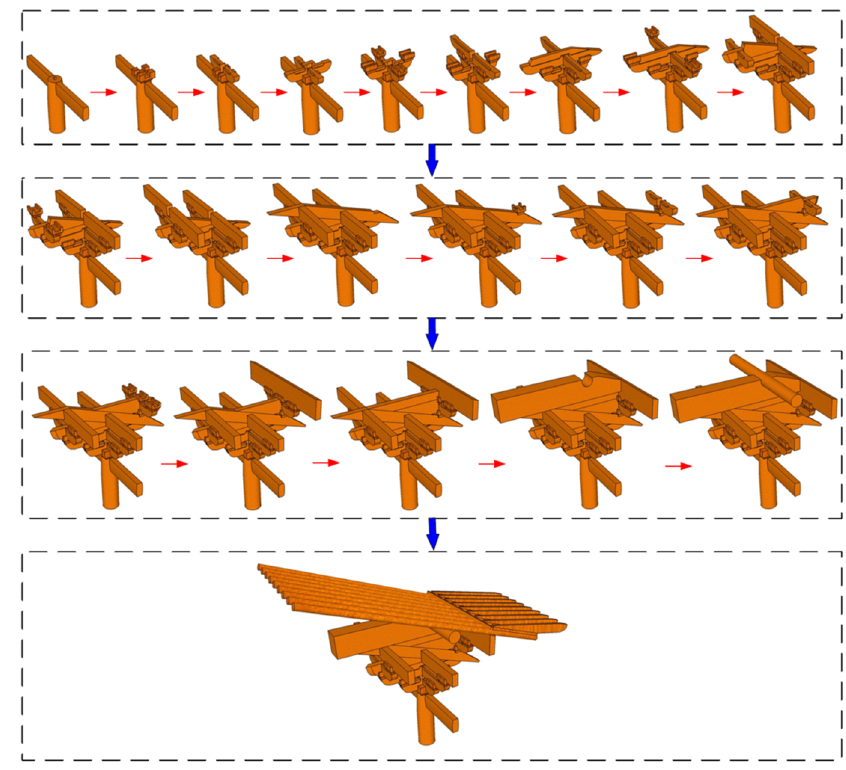
Figure 10. Typical assembly process of a Dougong bracket in Song dynasty.